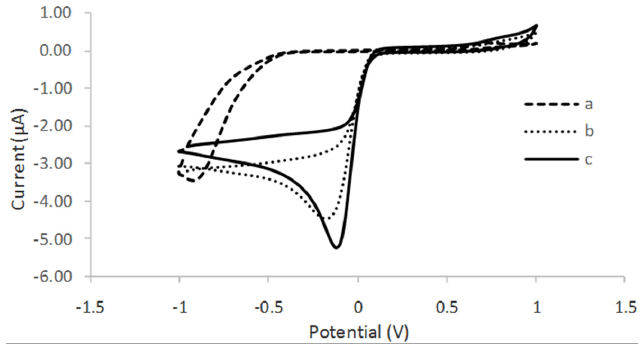
Figure 6. Cyclic voltamogram of ( a ) SPCE/tyrosinase; ( b ) SPCE/CTAB/PEG/tyrosinase; and ( c ) SPCE/CTAB/ZrO 2 -PEG/tyrosinase in the presence of 10 µM phenol in 50 mM phosphate buffer solution (PBS) pH 6.0.